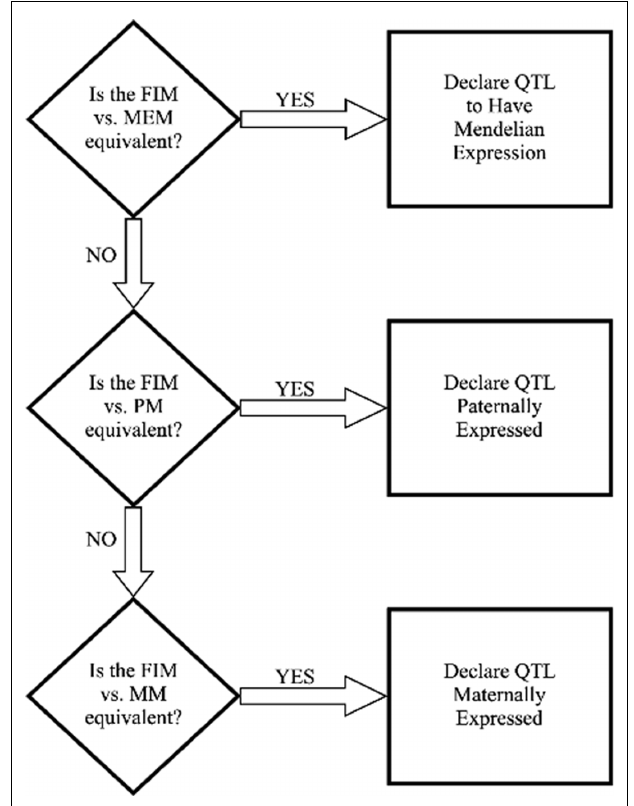
FIGURE 1 | Decision tree to compare different QTL models. FIM, full imprinting model; MEM, Mendelian model; MM, maternal model; PM, paternal